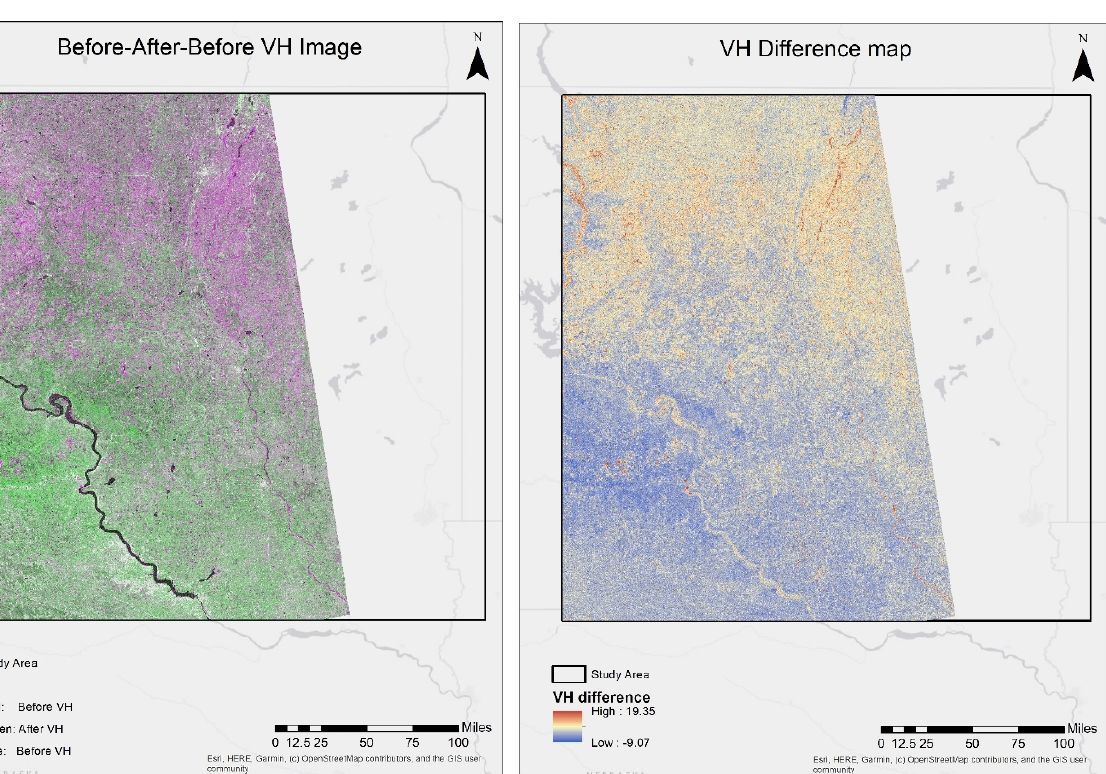
Figure 10. Histogram of VH difference showing just one major peak.